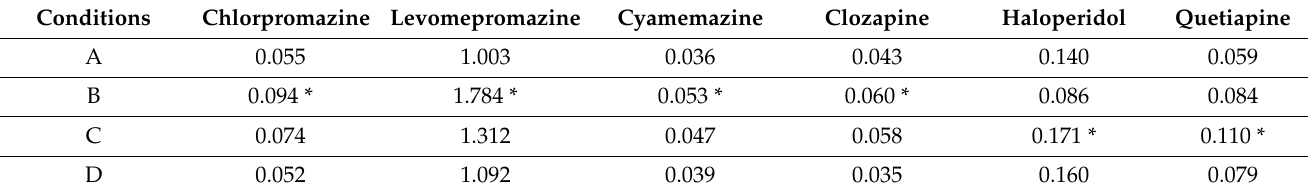
Table 1. Response of all analytes between first and seventh days of storage at conditions A, B, C, and